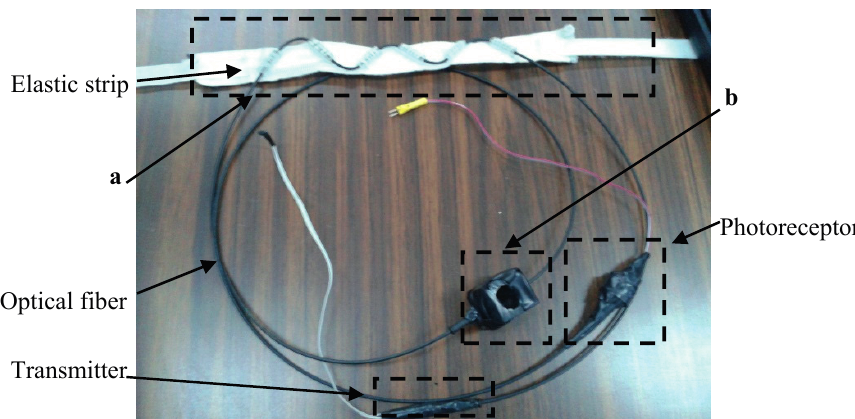
Figure 7. Respiratory rate ( a ) and heartbeat ( b )